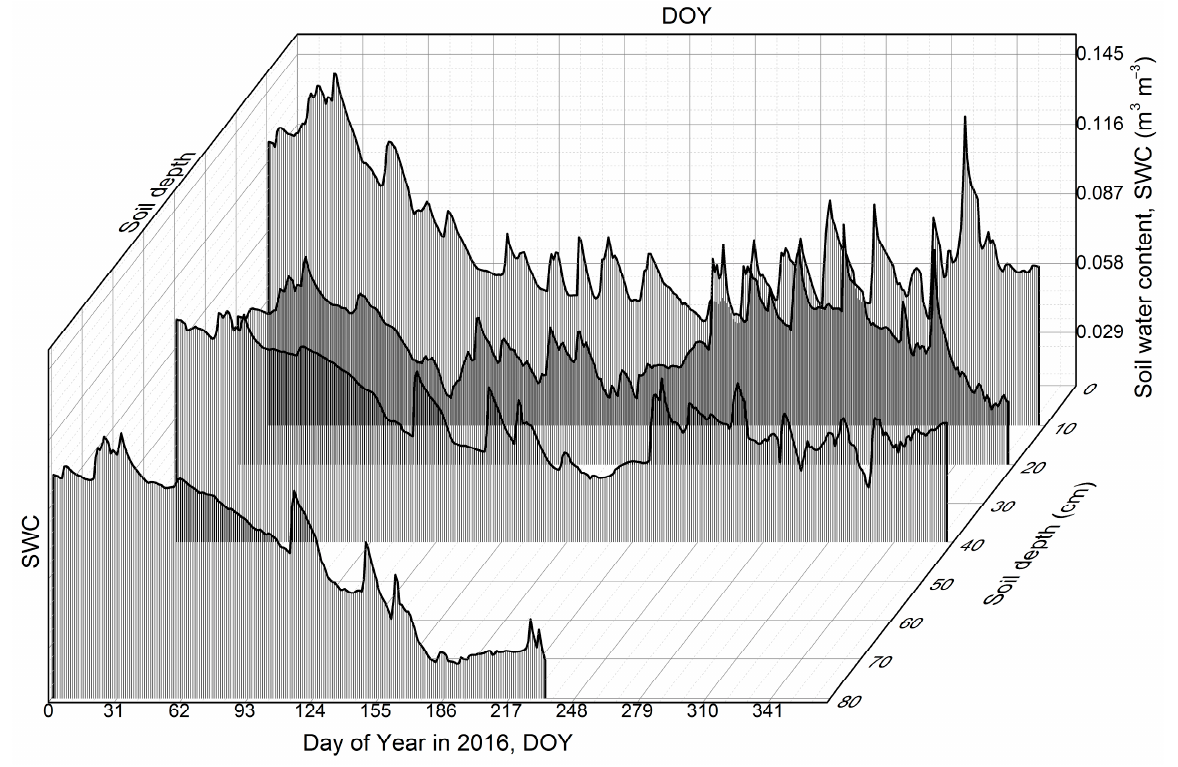
Figure 11. The seasonal variation of the soil water content (SWC) at different depths, shown as a waterfall figure. The SWC at an 80 cm depth had no data after the middle of the wet season due to sensor failure.